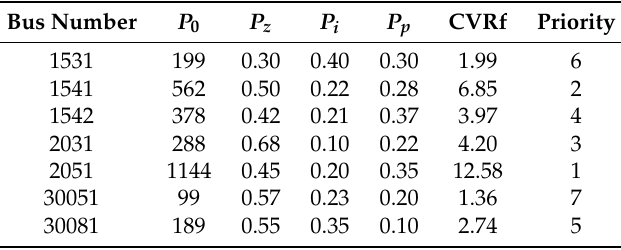
Table 2. ZIP coefficients, CVR factor, and